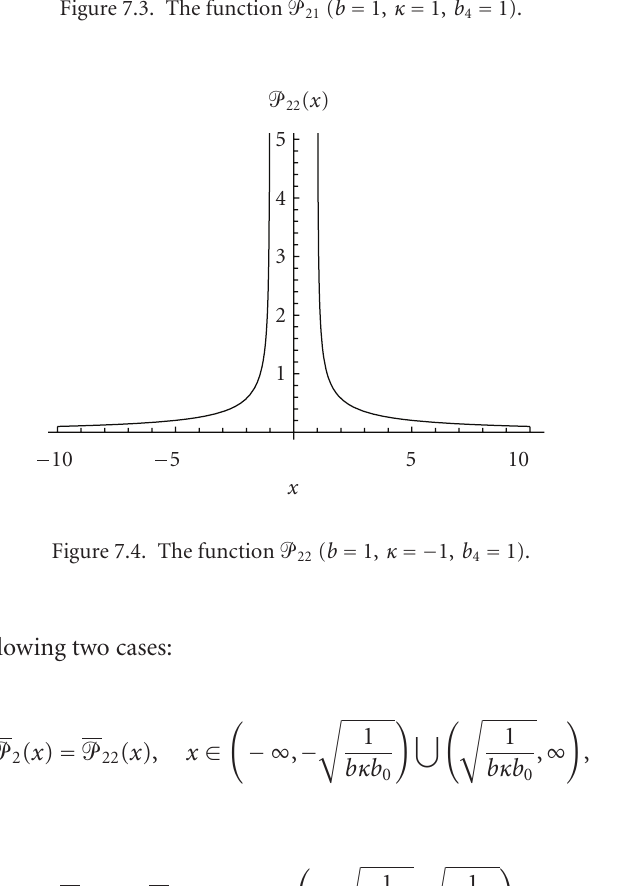
Figure 7.3. The function (cid:2) 21 ( b = 1, κ = 1, b 4 = 1).